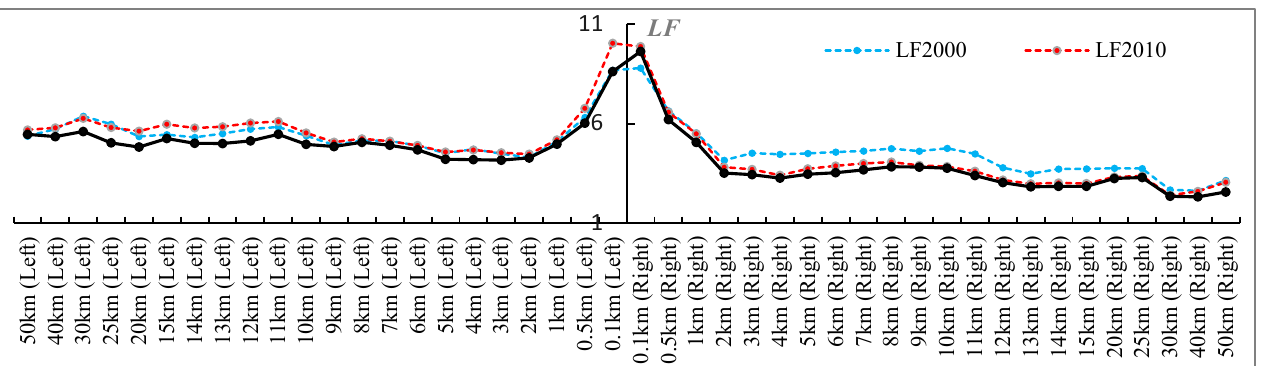
Figure 4. LF of 32 railway sections and different sides. ( a ) LF in 2000; ( b ) LF in 2010; ( c ) LF in 2020.